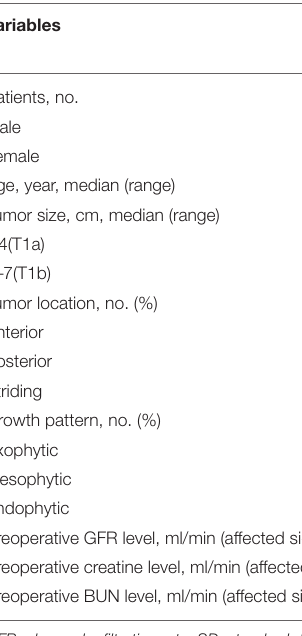
Novel suture suture group